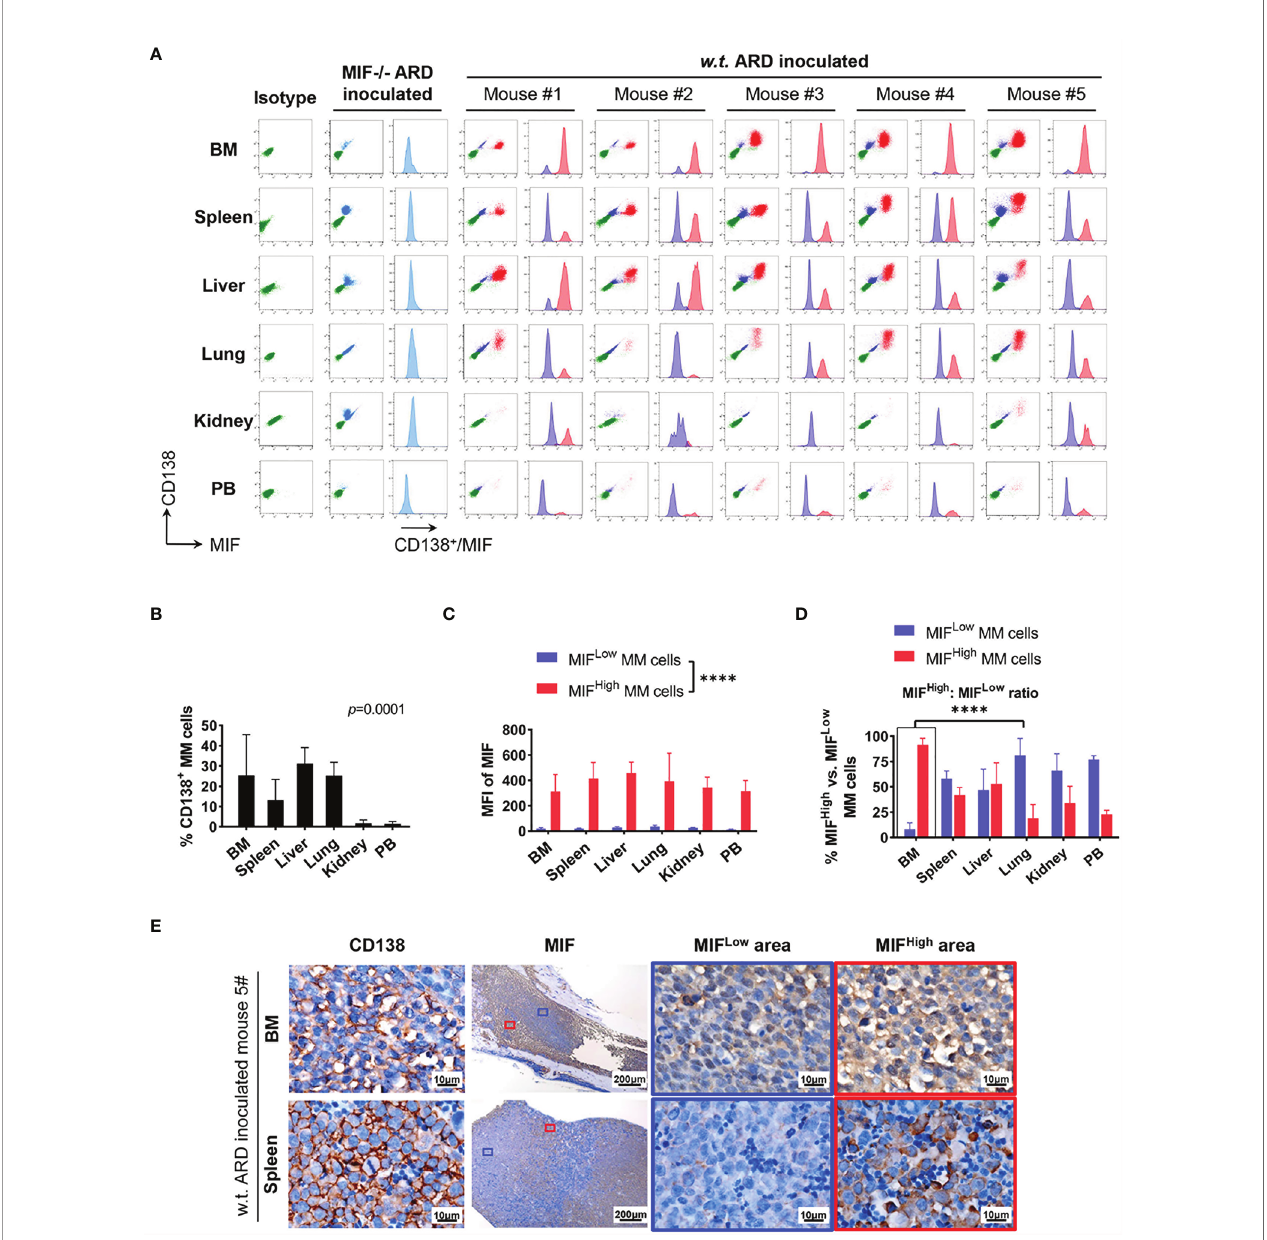
FIGURE 4 | Identi fi cation of MIF High and MIF Low MM cells in ARD cell line-derived xenografts. (A) B-NDG mice were intravenously injected with ARD cell line to establish another xenograft model (n = 5). Control mice received vehicle (PBS) or MIF − / − ARD cells. Three to four weeks after inoculation, samples were processed in the same way as described in the PDX model. Representative fl ow cytometry plots show MIF and CD138 expression in IMM and EMM (green, CD138 - cells, namely non-MM cells; light blue, MIF - MM cells; dark blue, MIF Low MM cells; red, MIF High MM cells). (B) CD138 + cells (ARD cells) in fi ltrate all tested samples with varying degrees. P = 0.0001 (two-way ANOVA). (C) MFI of MIF differs greatly between MIF High and MIF Low MM cells in diverse samples, with 373.4 ± 59.3 (MIF High ) versus 24.0 ± 8.1 (MIF Low ). **** p < 0.0001 (two-way ANOVA). (D) Signi fi cantly higher ratio of MIF High /MIF Low MM cells in BM versus extramedullary samples. **** p < 0.0001 (student ’ s t -test). (E) MIF High and MIF Low ARD cells in vivo are also identi fi ed by IHC. Representative images show their coexistence and more evident loss of MIF expression in spleen than in paired BM (the blue and red boxes indicate representative areas of MIF Low and MIF High MM cells,